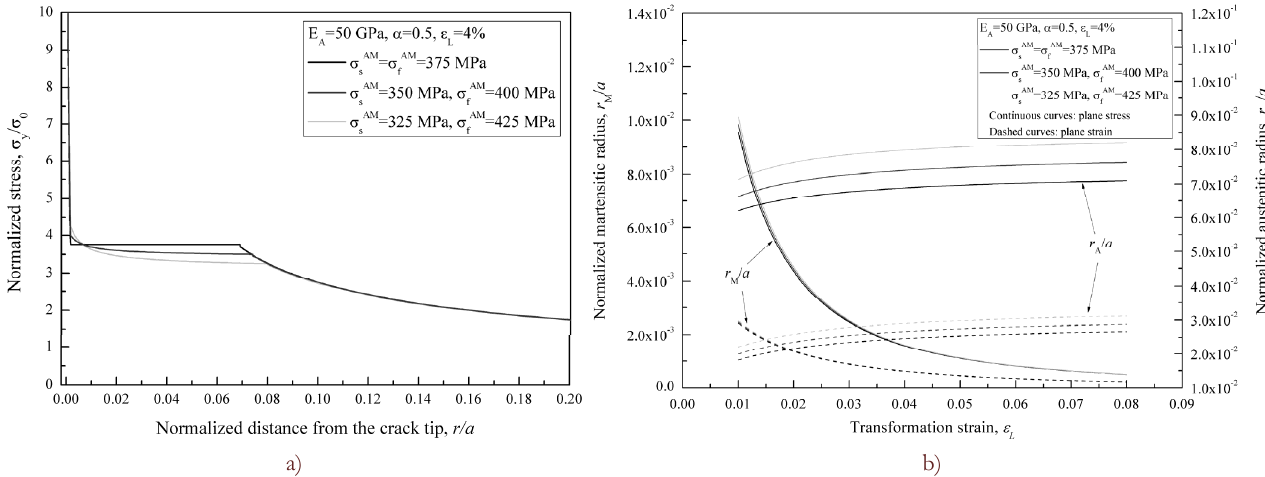
Figure 7: Effects of the slope of the stress-strain transformation curve: a) crack tip stress distribution and b) transformation radii [26].